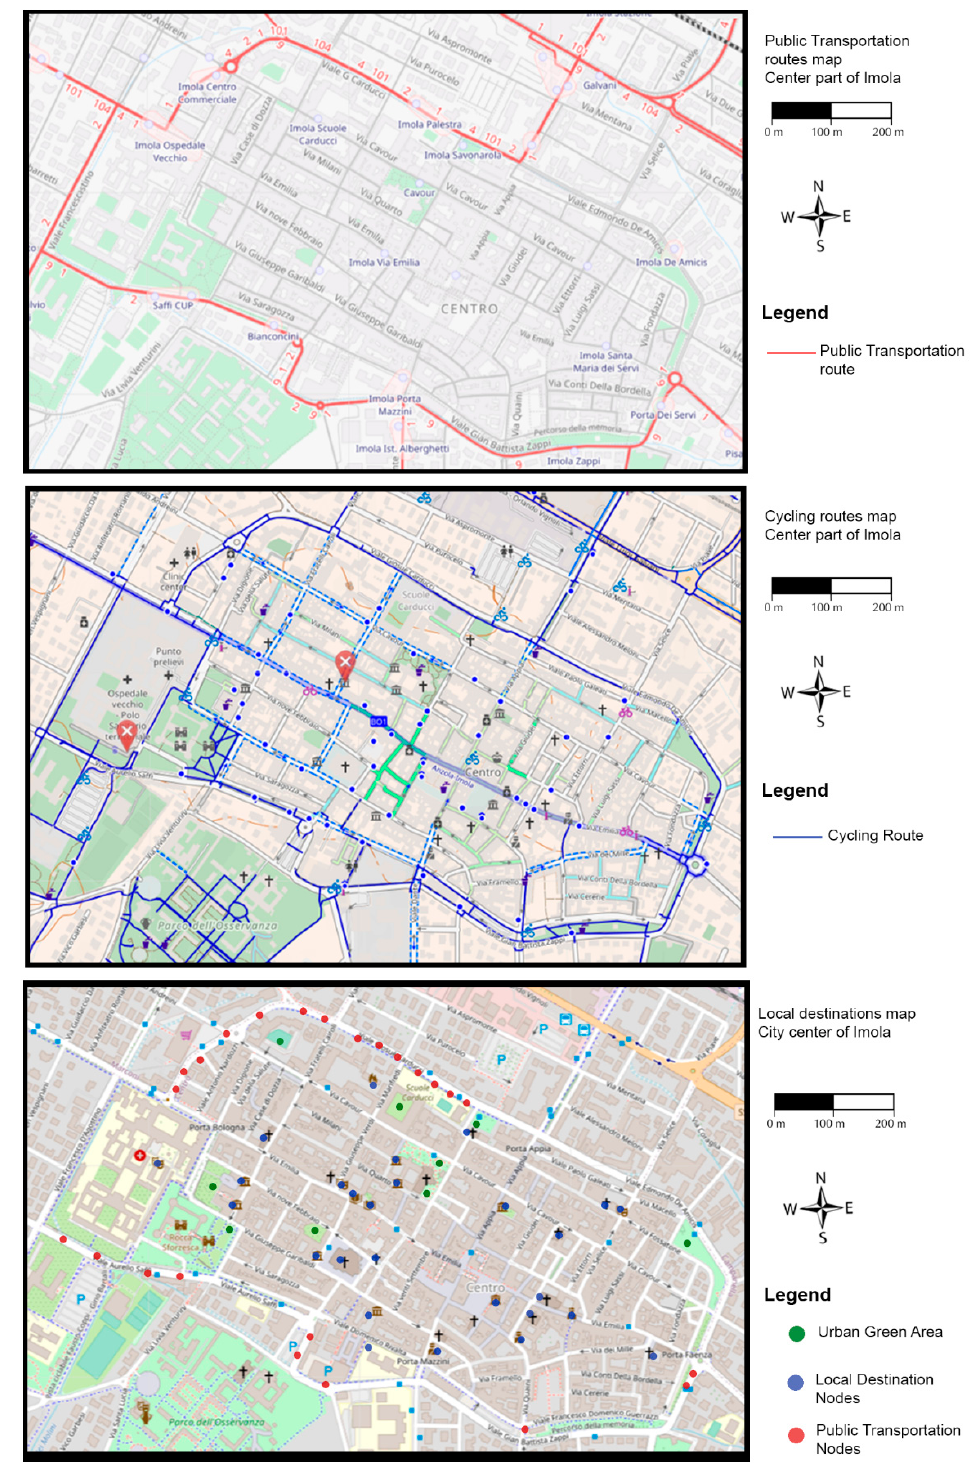
Figure 7. Maps of Public Transportation routes, Cycling routes, and Local Destinations.